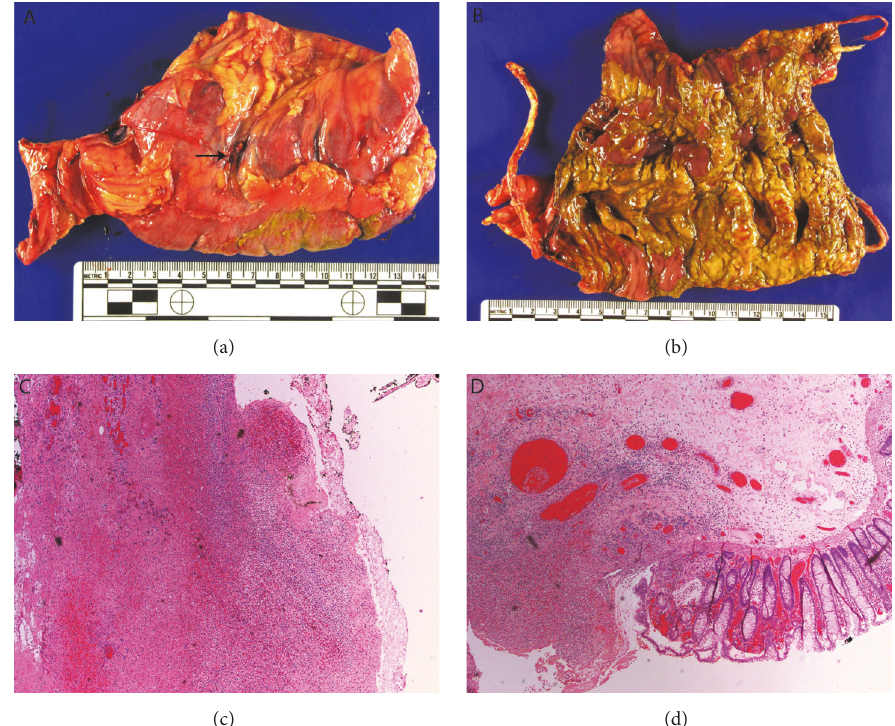
Figure 1: (a) perforation (arrow). (b) Colonic mucosa with yellowish exudate and multifocal ulcers. (c) Transmural necrosis (H&E). (d) Ulcer and adjacent colonic